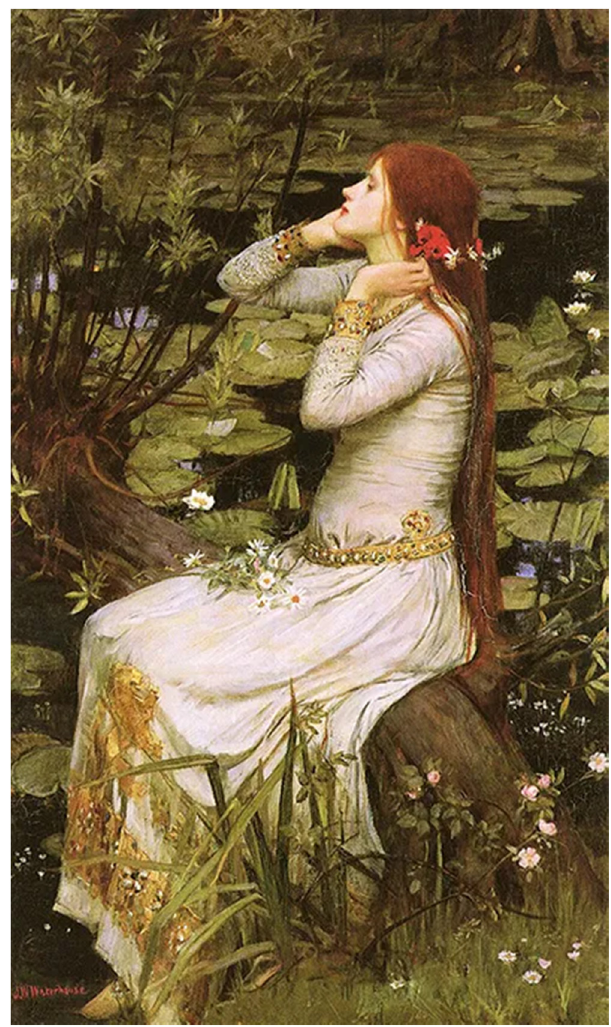
Figure 2: John William Waterhouse, “ Ophelia, ” 1894, oil on canvas. https://www.john - william - waterhouse.com/ophelia -